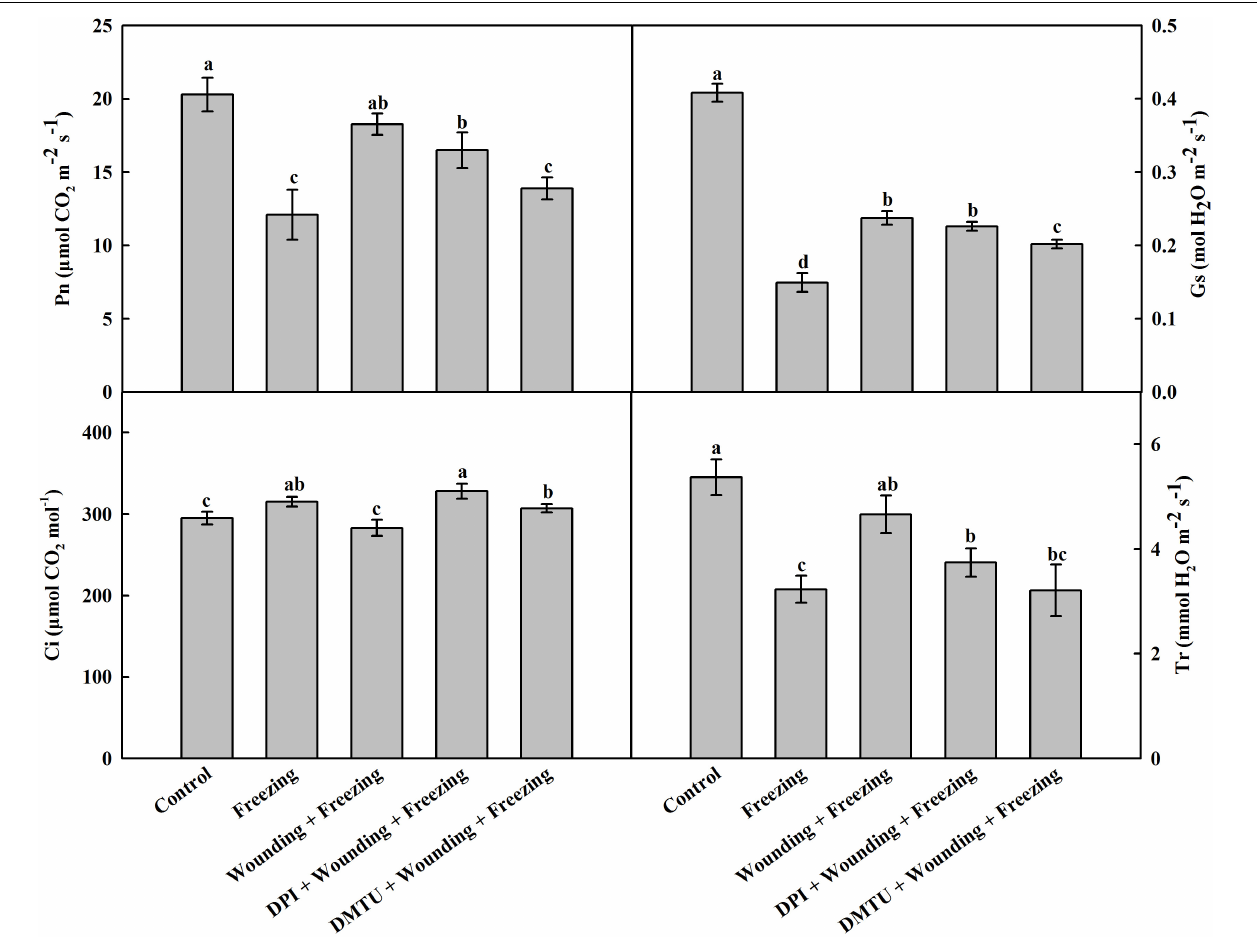
FIGURE 2 | Effect of mechanical wounding on gas exchange in the local and the systemic leaves of wheat under freezing stress. Pn, photosynthetic rate; Gs, leaf stomatal conductance; Ci, internal CO 2 content; Tr, transpiration rate. The local (fifth) leaves were separately pre-treated with distilled water, 5 mM DMTU or 100 µ M DPI prior to wounding. At 10 days after wounding, the seedlings were exposed to freezing stress for 24 h. After 24 h recovery, gas exchange parameters were measured on the systemic leaves with a portable photosynthesis system. Data are mean values ± SD of three independent replicates. Means denoted by different letters indicated significant difference at P < 0.05 according to Tukey’s